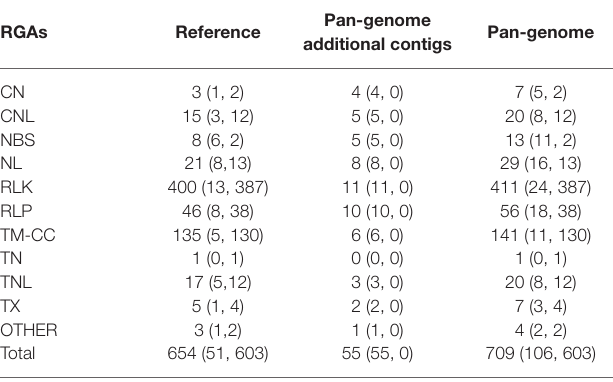
TABLE 1 | The number of different types of resistance gene analog (RGA) candidates and subfamilies found on the reference genomes and pan-genome additional